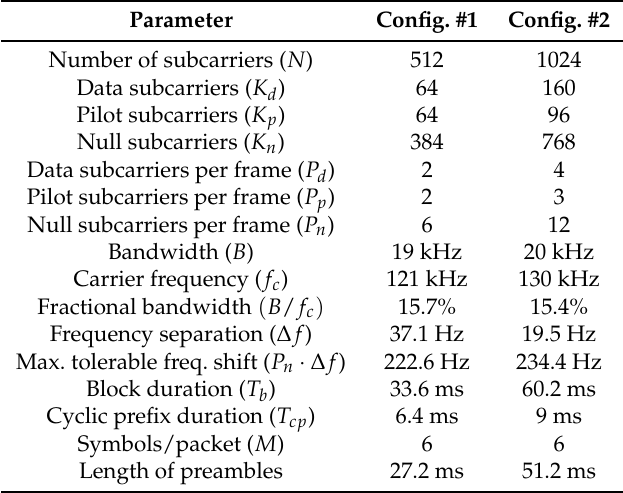
Table 2. OFDM parameters for the two short-range